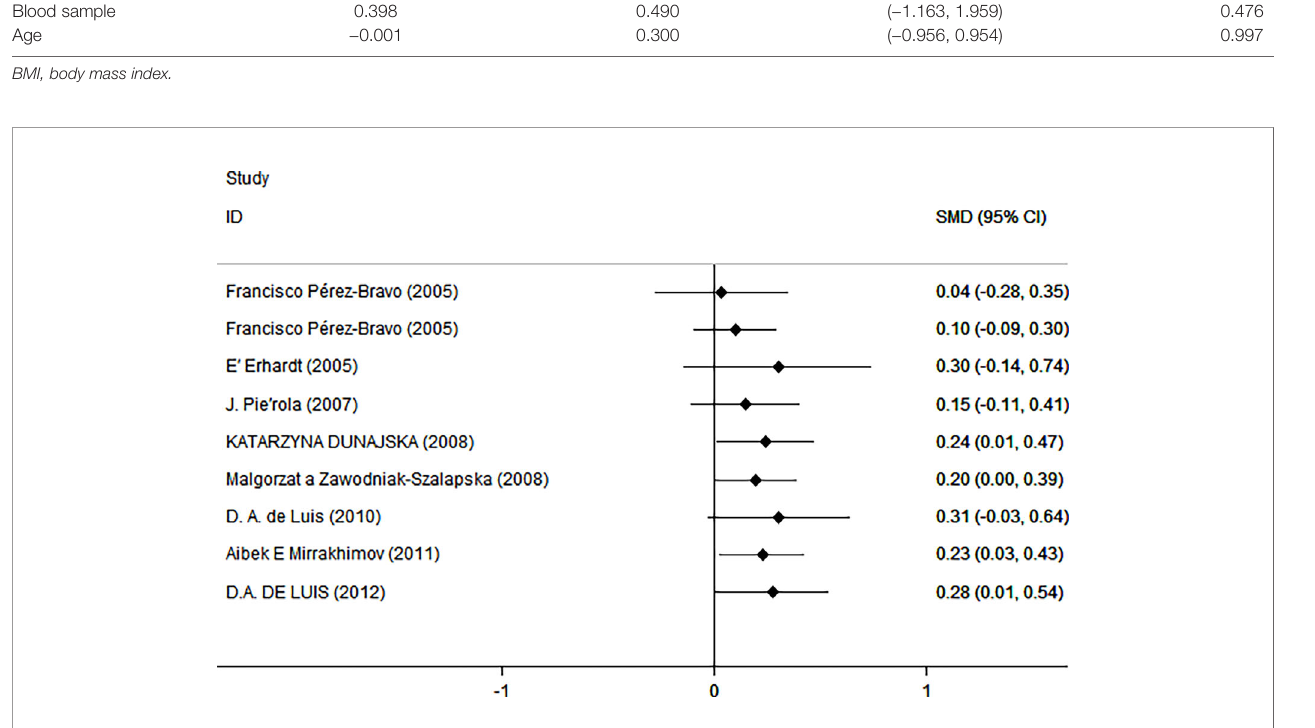
TABLE 3 | Meta-regression of correlations between Trp64Arg and insulin resistance.